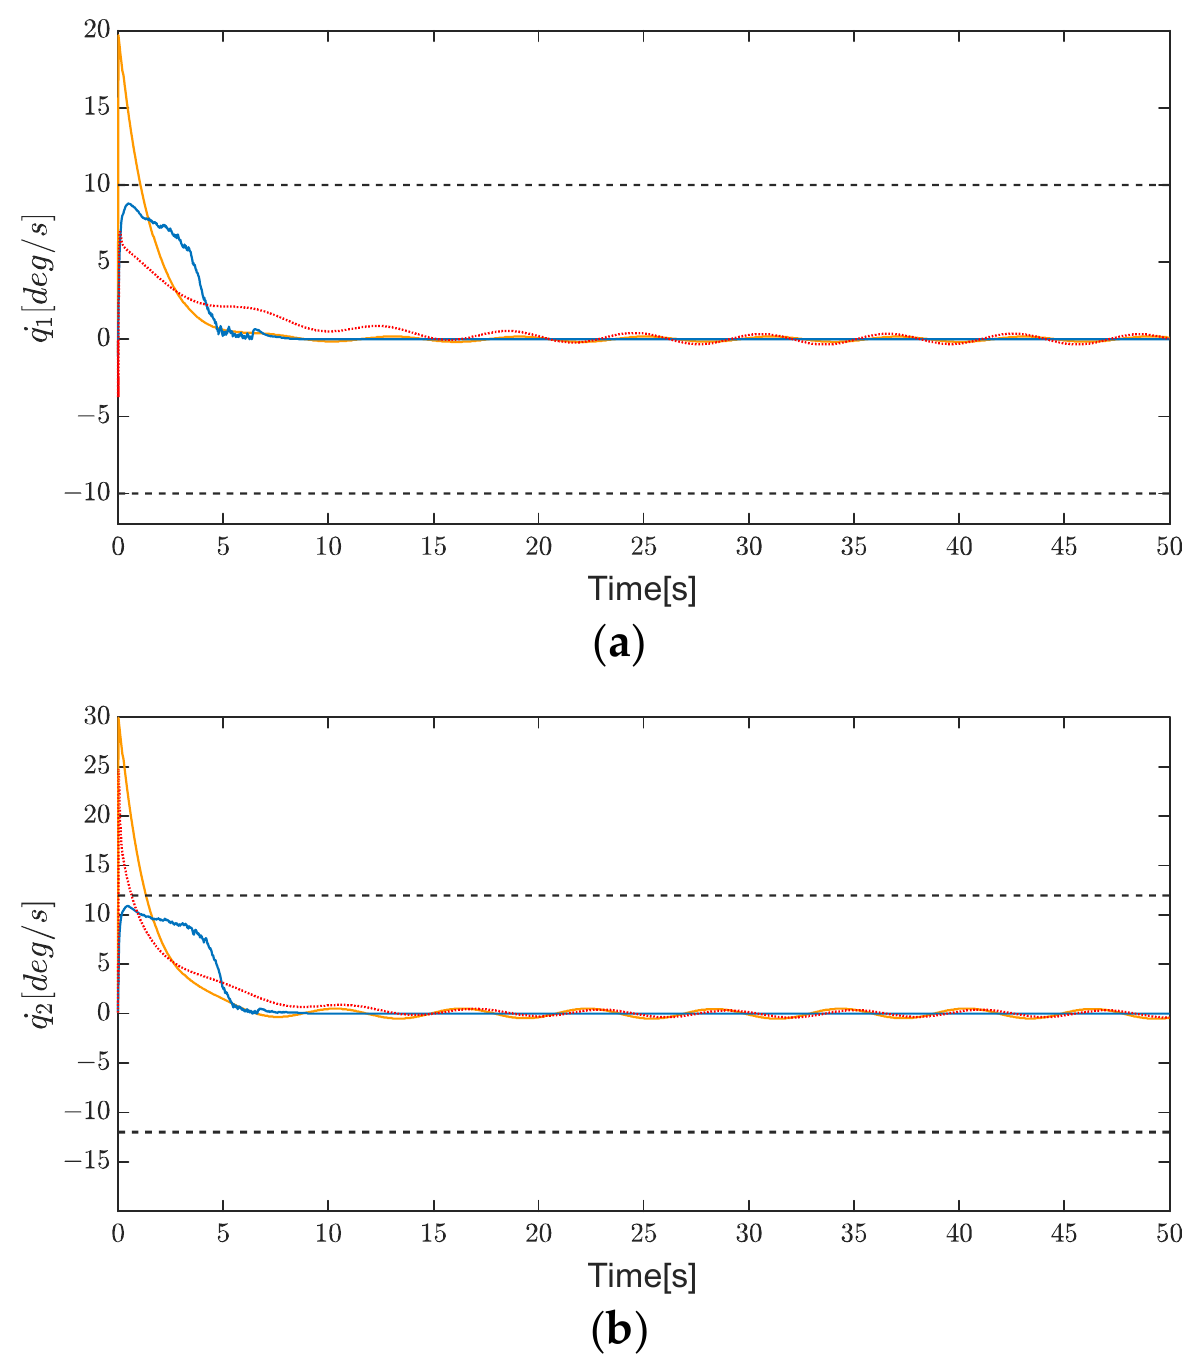
Figure 13. Comparison of angular position to [43,44] in case 2: The [43] scheme (yellow solid line), the [44] scheme (red dash line), the proposed scheme (blue solid line), the reference angular position (green dashed line), the angular position constrains (black dashed line); ( a ) Joint 1. ( b ) Joint 2.